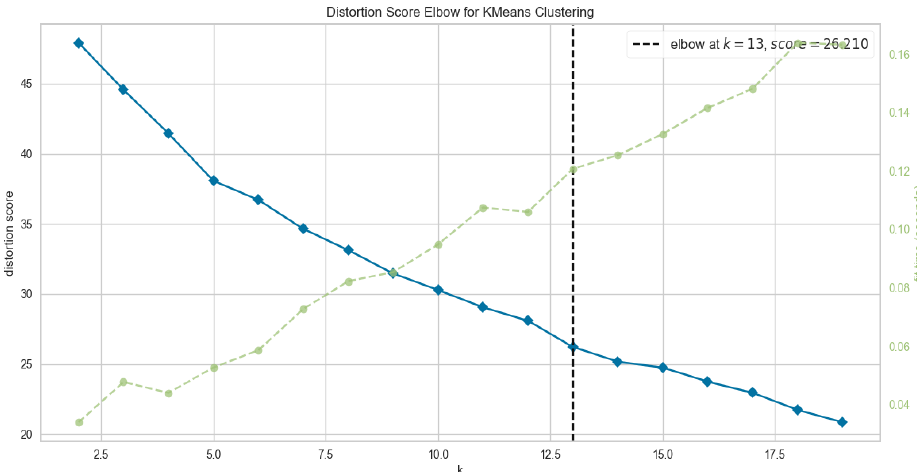
Figure 6. Optimal number of clusters using elbow method.